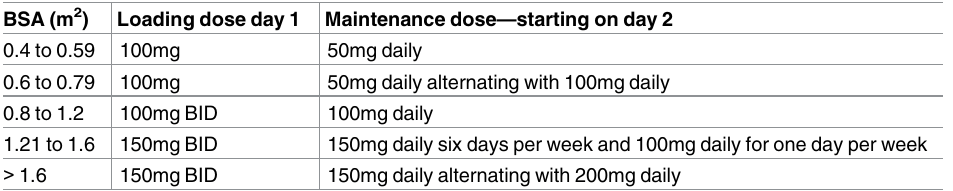
Table 4. Perifosine dose level 4 (~100 mg/m 2